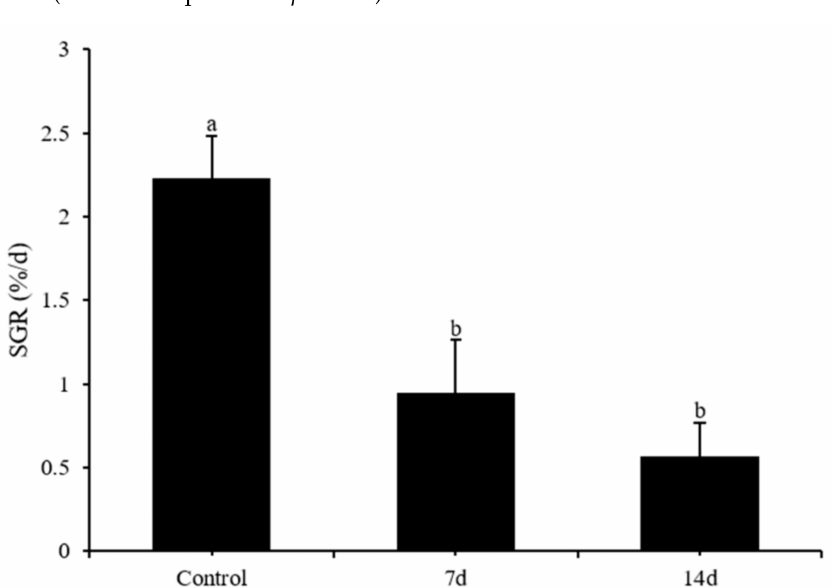
Figure 2. Effects of 7 and 14 days of the UCS protocol on the specific growth rate (SGR) in the rare minnow. Data are expressed as mean ± SD (n = 3). The different letters in the bar indicate significant differences between the two groups ( p <